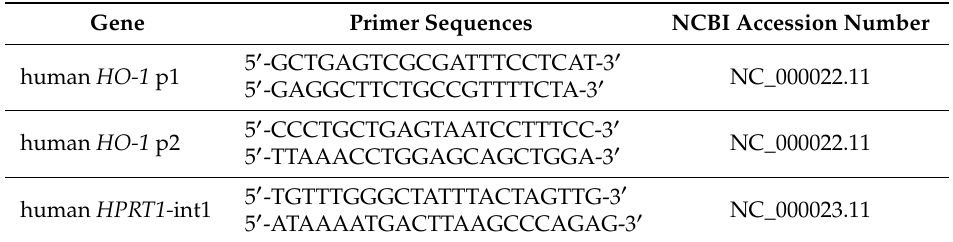
Table 2. Primer sets for